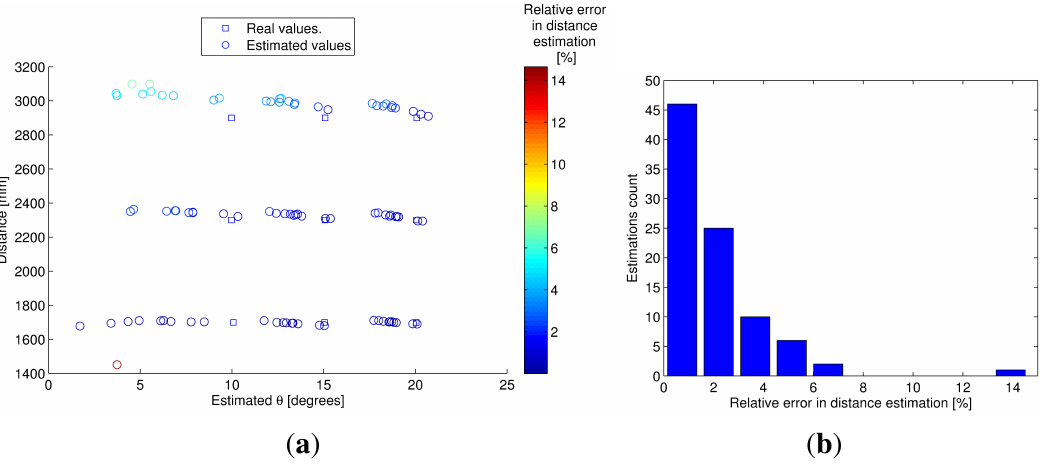
Figure 13. Results of the distance and IRED orientation angle estimation using random bias currents in the IRED. ( a ) Distance and IRED orientation angle estimation. The ( x, y ) coordinates represent the estimated θ and d , respectively. The squares are the true coordinates used in the experiment and the circles are the estimated values. The color of the circles represents the relative error in [%] of the estimated distance. ( b ) Histogram of relative errors in distance